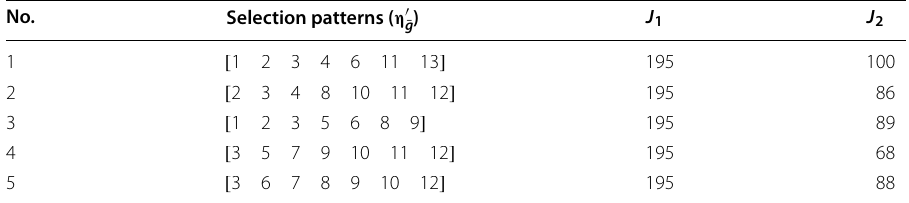
Table 4 Five information selection patterns from 128 patterns that result in min ( J 1 ) and min ( J 2 ) No. Selection patterns ( η ′ ¯ g